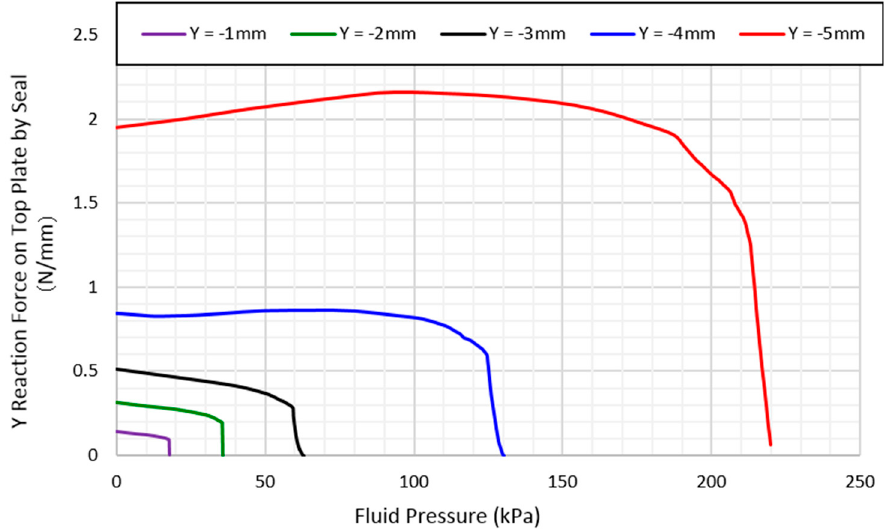
Figure 14. Waterproof performance of EPDM seal for a variety vertical displacement. Plane stress (1.5 m), COF = 0.1.